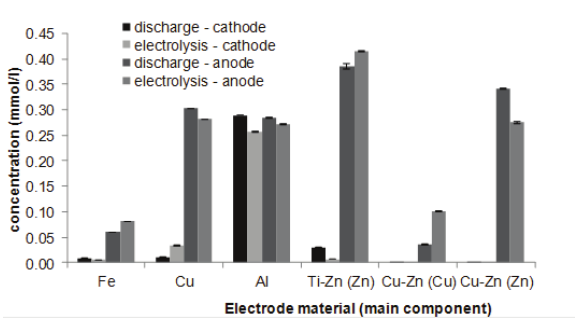
Figure 4 : Comparison of metal amount detected by ICP analysis, various electrodes. Table 1 : Comparison of hydrogen peroxide production efficiency for different electrode